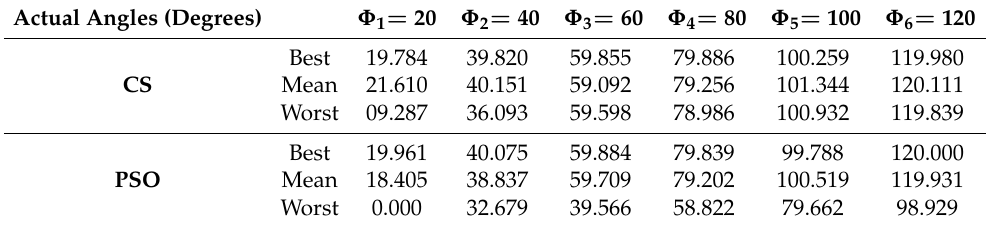
Table 2. Calculation of accuracy for six targets at − 5 dB SNR.